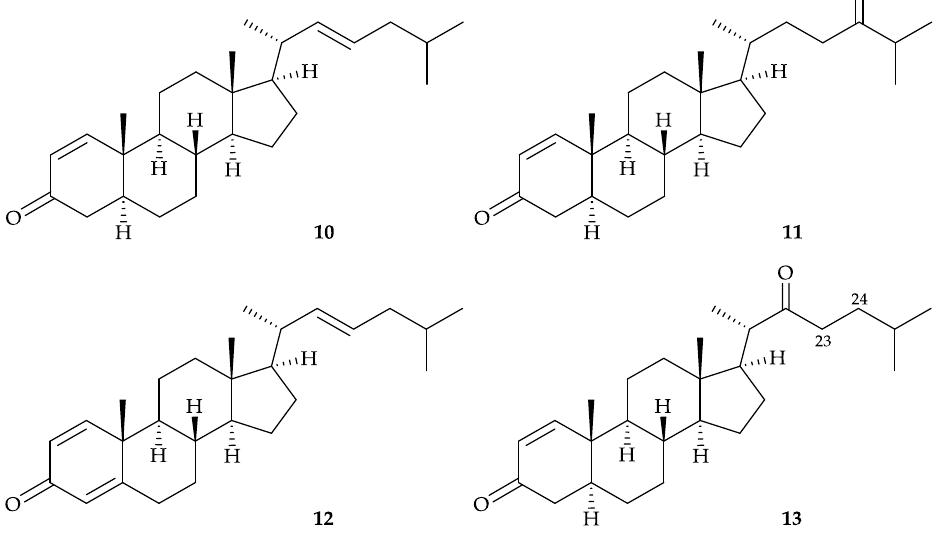
Figure 3. Structures of dendronesterones A–C ( 10 – 12 ) and cholest-1-ene-3,22-dione ( 13 ).